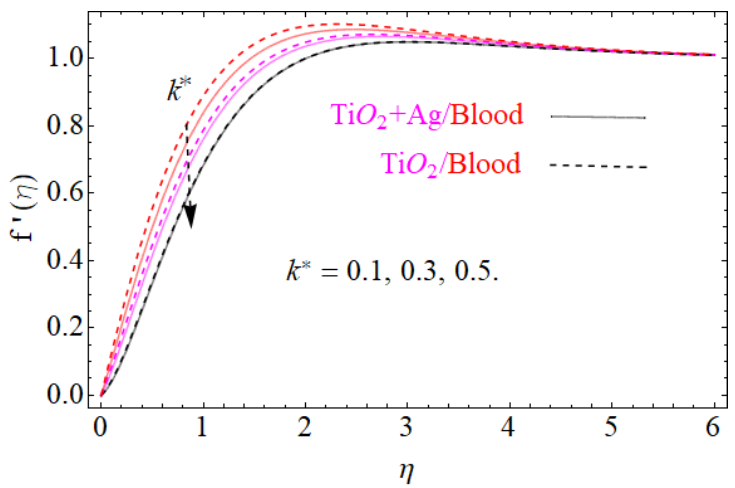
Figure 5. Effect of kinematic viscosity on velocity profile.